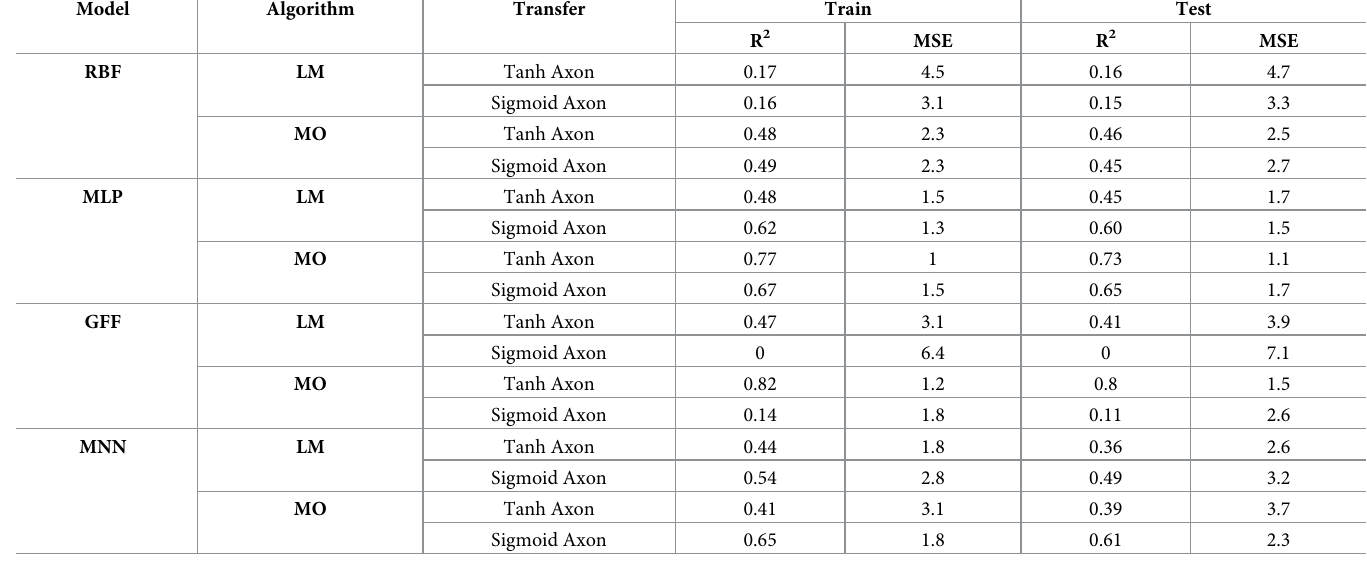
Table 2. Comparison of four models developed in training and testing stages.